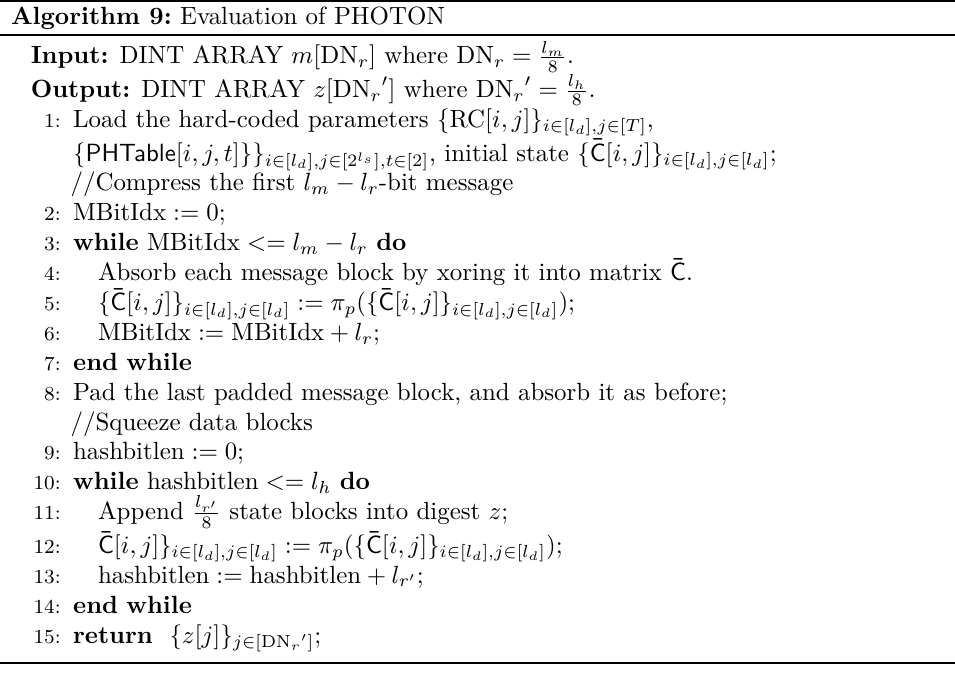
Algorithm 9: Evaluation of PHOTON